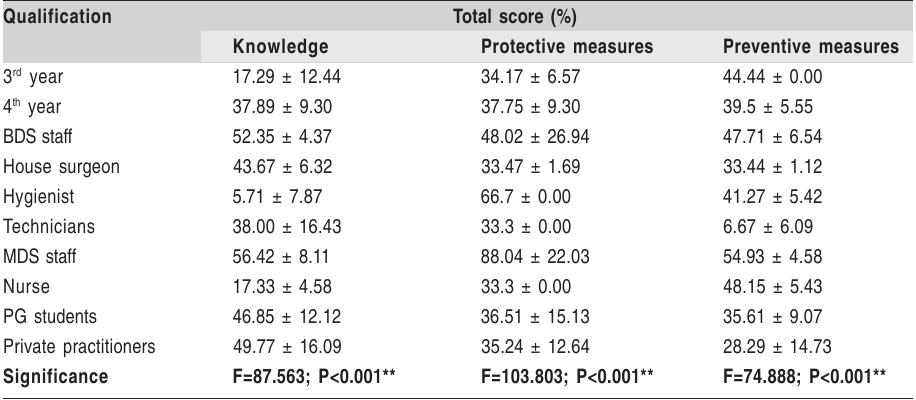
Table 2 - Correlation of total score (%) of positive response of knowledge, protective and preventive measures adopted.